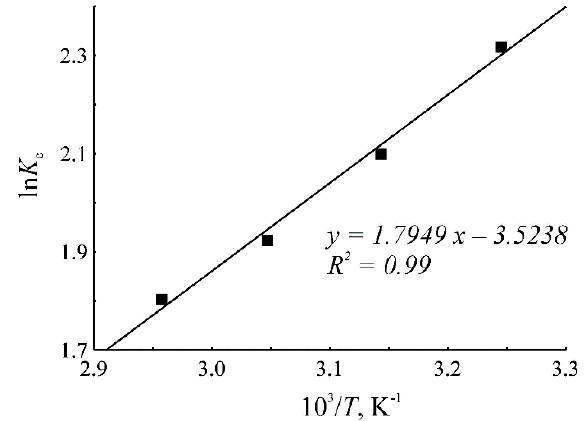
Figure8. Dependenceofthelogarithmofthedistributionconstantofbenzeneontheinversetemperature Figure 8. Dependence of the logarithm of the distribution constant of benzene on the inverse during adsorption onto the HKUST-1 mw temperature during adsorption onto the HKUST-1 mw sample.